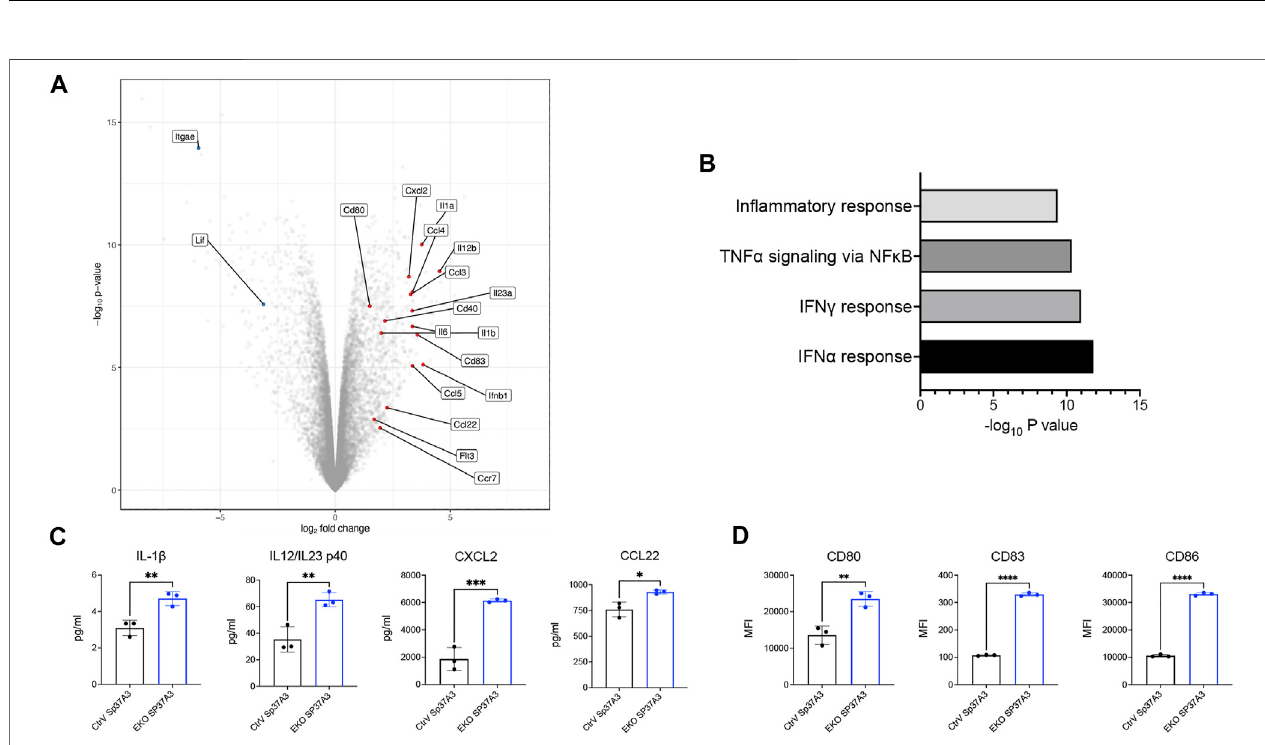
FIGURE 4 | Siglec-E-de fi cient DCs showed elevated maturation status upon stimulation. (A) Volcano plot of differentially expressed genes between EKO SP37A3 and CtrV Sp37A3 cells. (B) GSEA of the most signi fi cantly activated pathways in EKO Sp37A3 cells. (C) Cytokine and chemokine production and (D) activator and co- stimulatory markers of CtrV (black) and EKO (blue) Sp37A3 cells. Data are presented as mean (±SD), and unpaired t test was used for one-way comparisons (* p < 0.0332, ** p < 0.0021, *** p < 0.0002, and **** p < 0.0001).